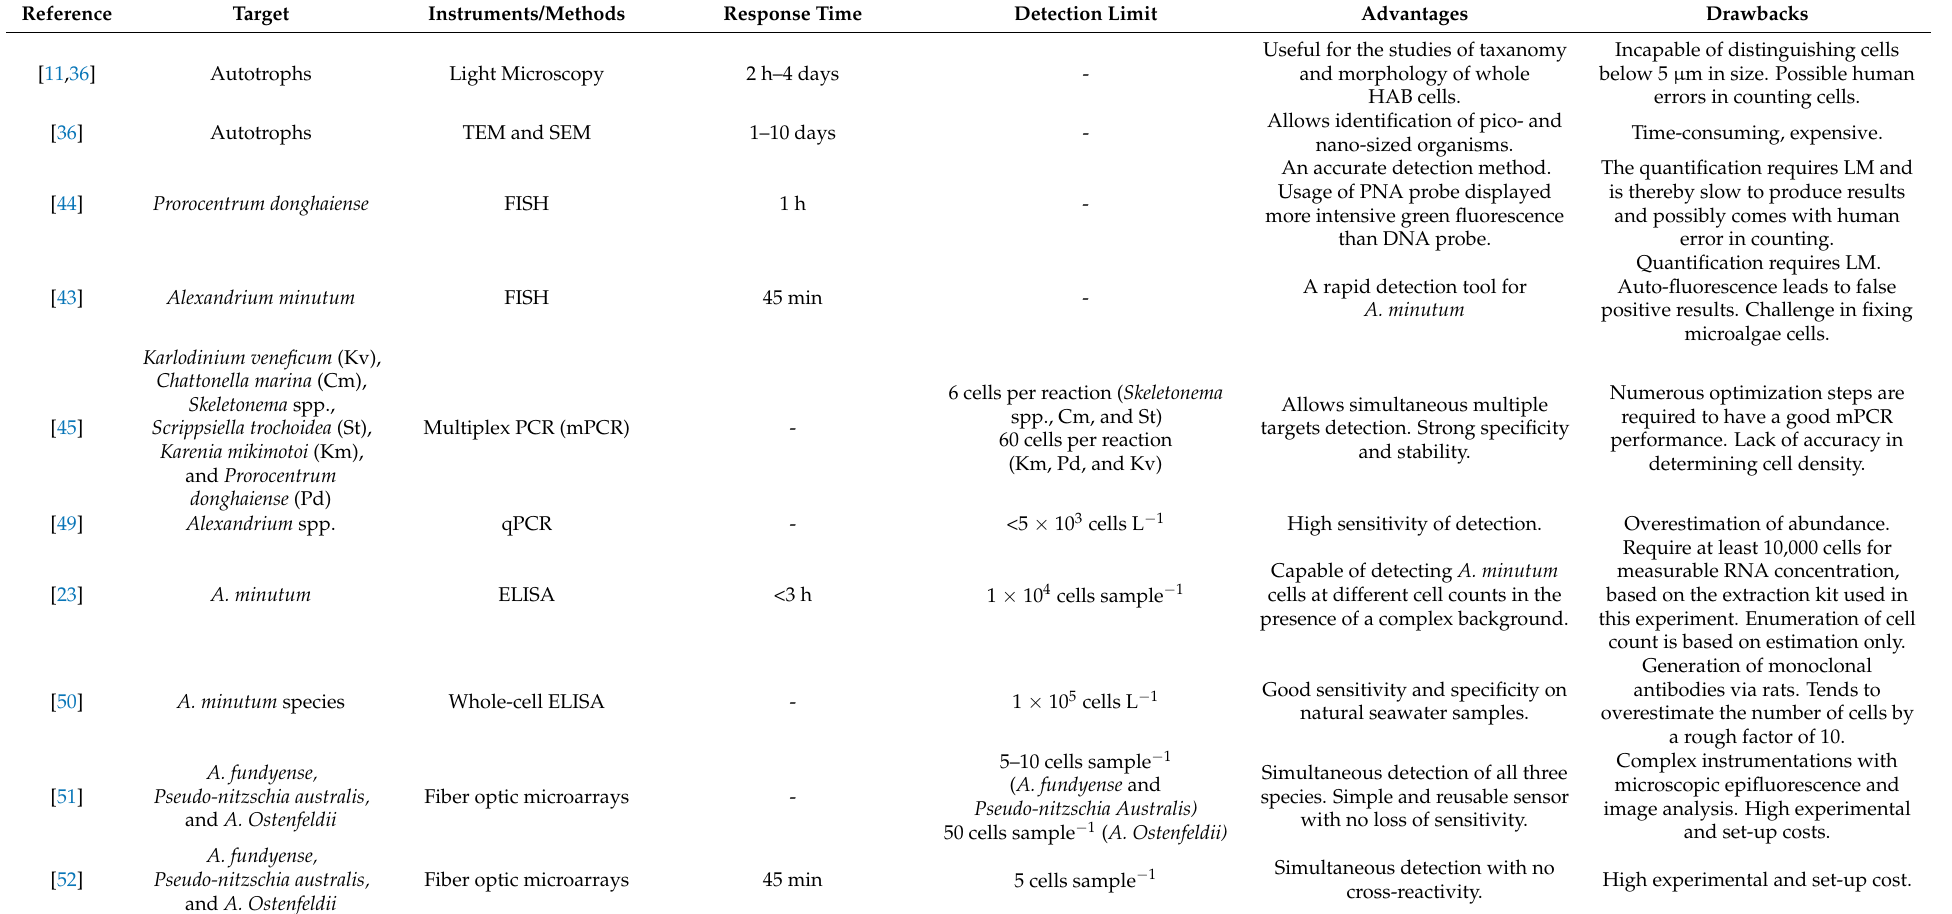
Table 1. Summary of the previously reported molecular biological methods for the detection of HAB